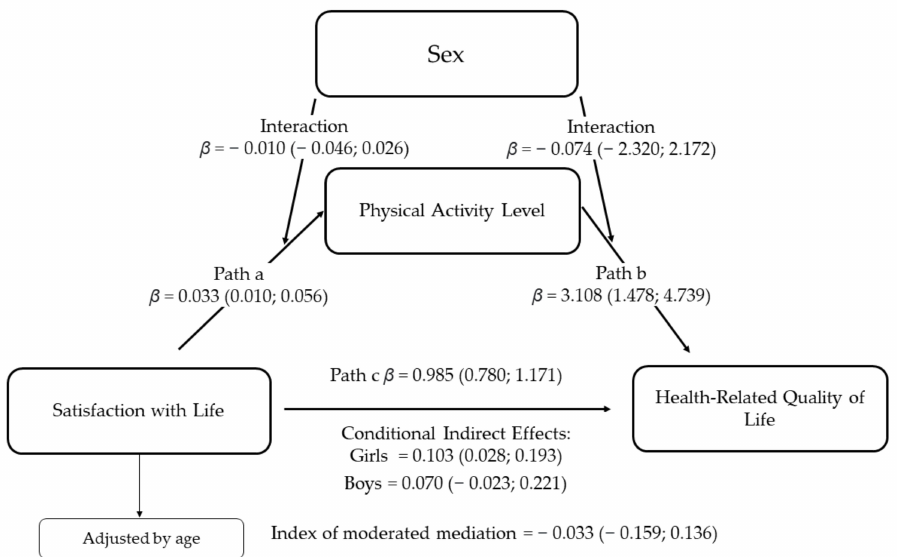
Figure 2. Moderated-mediation analysis of the relation between satisfaction with life and HRQoL mediated by physical activity level and moderated by sex. This model was adjusted by age and the number of bootstrap samples was 5000. Path a = association between satisfaction with life and physical activity level; Path b = association between physical activity level and HRQoL; Path c = direct effect of the satisfaction with life and HRQoL.